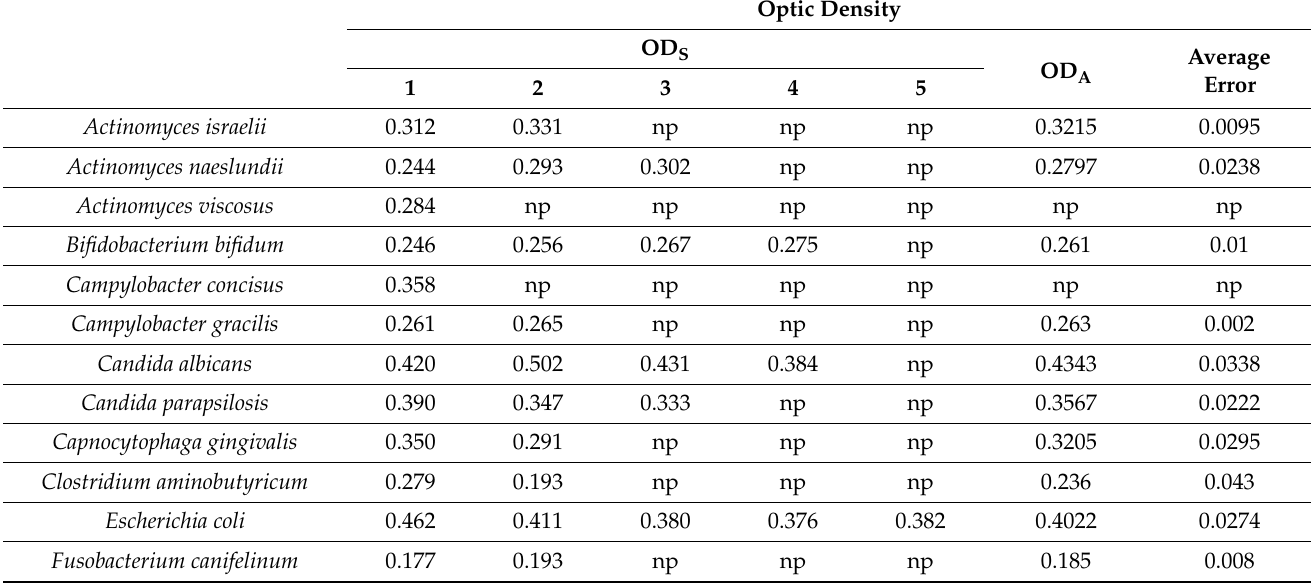
Table 2. Determination of bacterial biofilm formation intensity by optic